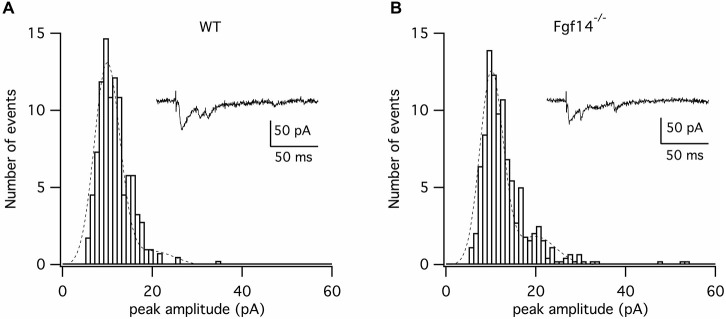
Asynchronous quantal PF-EPSCs are not affected by genetic deletion of Fgf14. Cumulative plots of asynchronous EPSCs size following parallel fiber stimulation. Amplitude histograms were fitted (dashed lines) by a multipeak gaussian function to detect the size of unitary quantal events of Fgf14+/+
(A) and Fgf14−/−
(B) mice. Representative traces are shown in the insets.